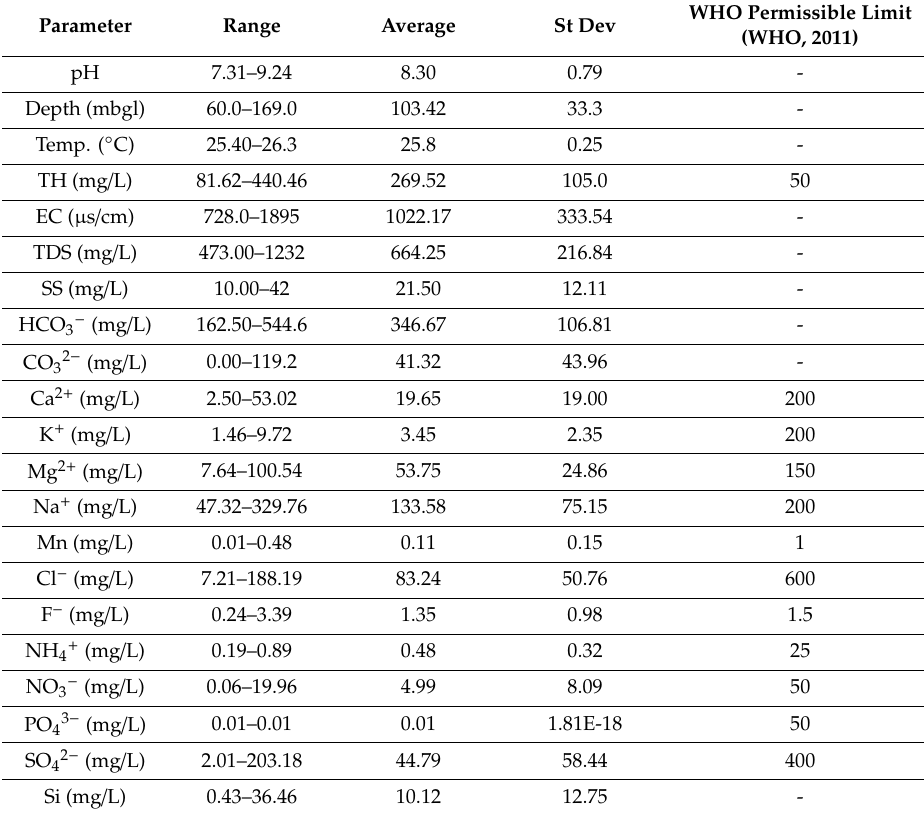
Table 2. Statistical summary of groundwater quality in the study